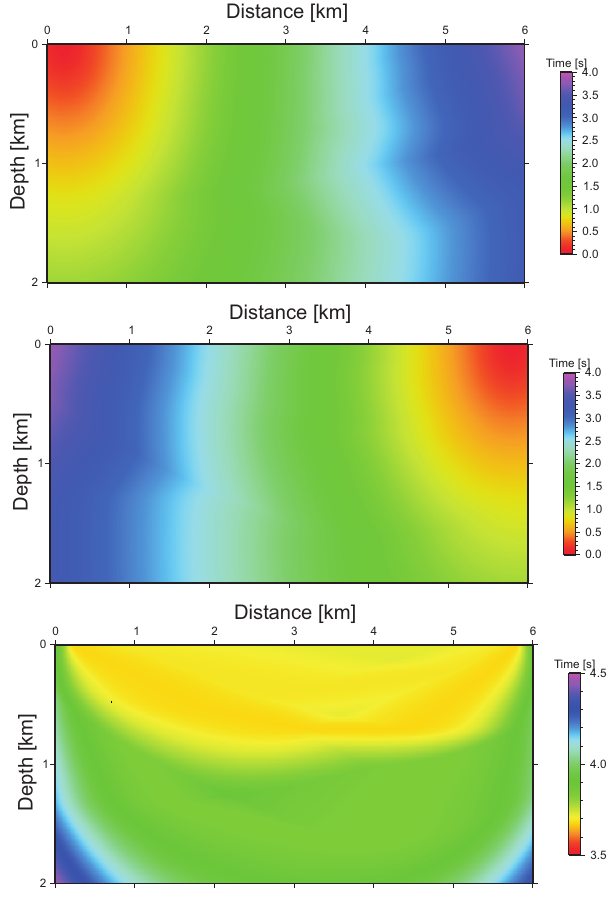
Fig. 2. Traveltime tables for the source at x = 0 . 2km (top) for the receiver at x = 5 . 8km (middle) and the sumation of both timetables (bottom). These traveltime tables were obtained using a finite dif- ference solution of the eikonal equation (Hole and Zelt, 1995). The yellow and orange colors indicate the zone of minimum traveltimes. This ilustrates the fastest path from the source to the receiver within the model (the banana-kernels). This ilustrates that the scheme used is able to handle long-o ff sets.